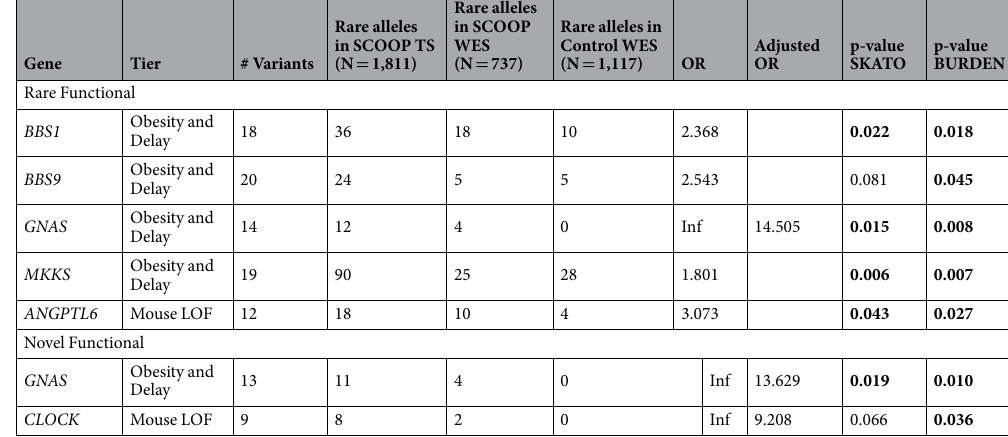
Table 1. Summary of case-control results. Summary of case-control results in genes with nominally significant (p-value < 0.05, bold) burden of Rare (top) or Novel (bottom) functional variants in SCOOP cases (N = 1,811 with targeted sequence and N = 737 with whole-exome sequence), compared to 1,117 controls with whole- exome sequence data from the UK10K project. The number of variants (# variants) per gene are shown, as well as the number of alleles in cases and controls, odds ratios (OR) and p-values from SKAT-O (p-value SKATO) and from burden tests (p-value BURDEN). For variants not detected in controls an adjusted odds ratio (Adjusted OR) was calculated by adding 0.5 to the number of alleles in each cell of the two-by-two